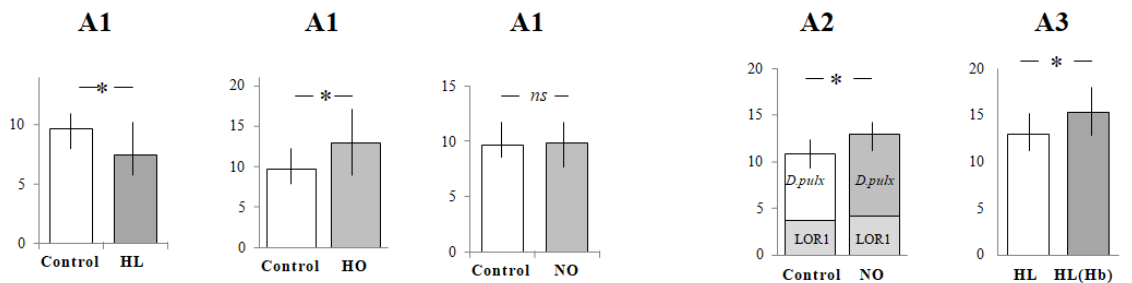
Figure 3. Wilcoxon test results for Hypotheses 1, 2, 3. * Statistically significant ( p < 0.05); ns not significant Table 1. Results of the experiments testing Hypotheses 1, 2, 3.